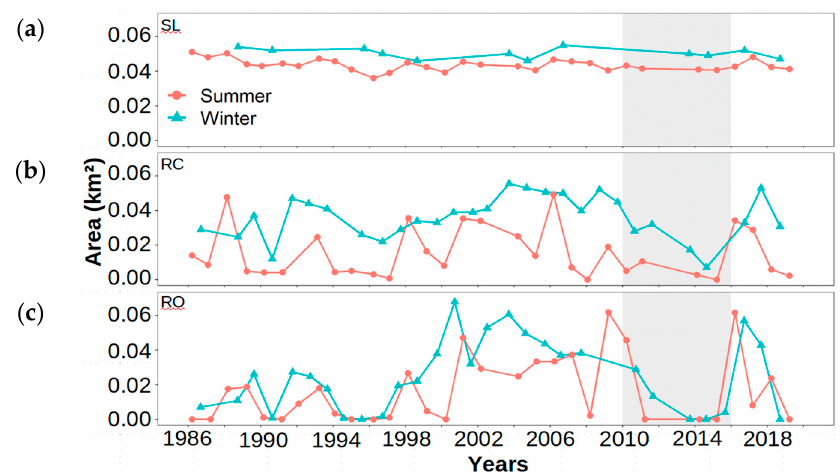
Figure 6. Mean winter (June-July-August) and summer (January–February–March) area of the three main water bodies of the Petorca basin between 1986 and 2019, for ( a ) El Sobrante lagoon (SL), ( b ) Colorado brook dam (RC), and ( c ) Ossandon brook dam (RO). Shaded area corresponds to the MD period.